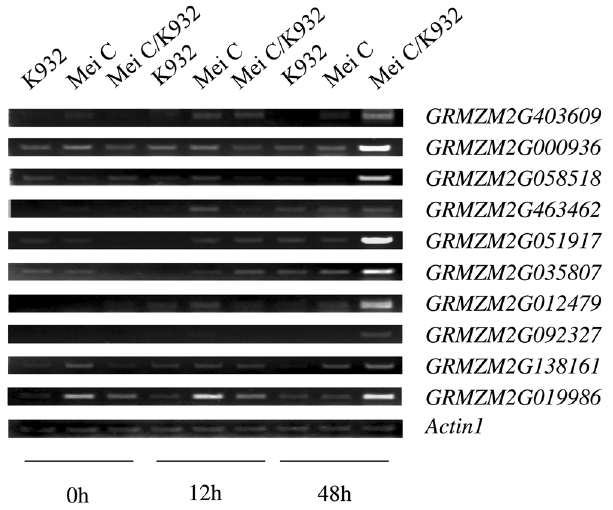
Figure 1. Expression of the 10 candidate genes in the two parents and their hybrid under chilling